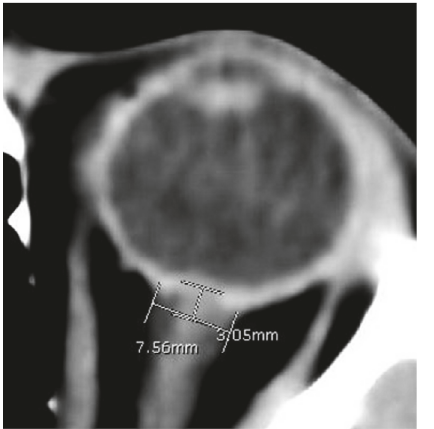
Figure 2: Showing a CT scan with an ONSD of 7.56mm measured 3 mm posterior to the